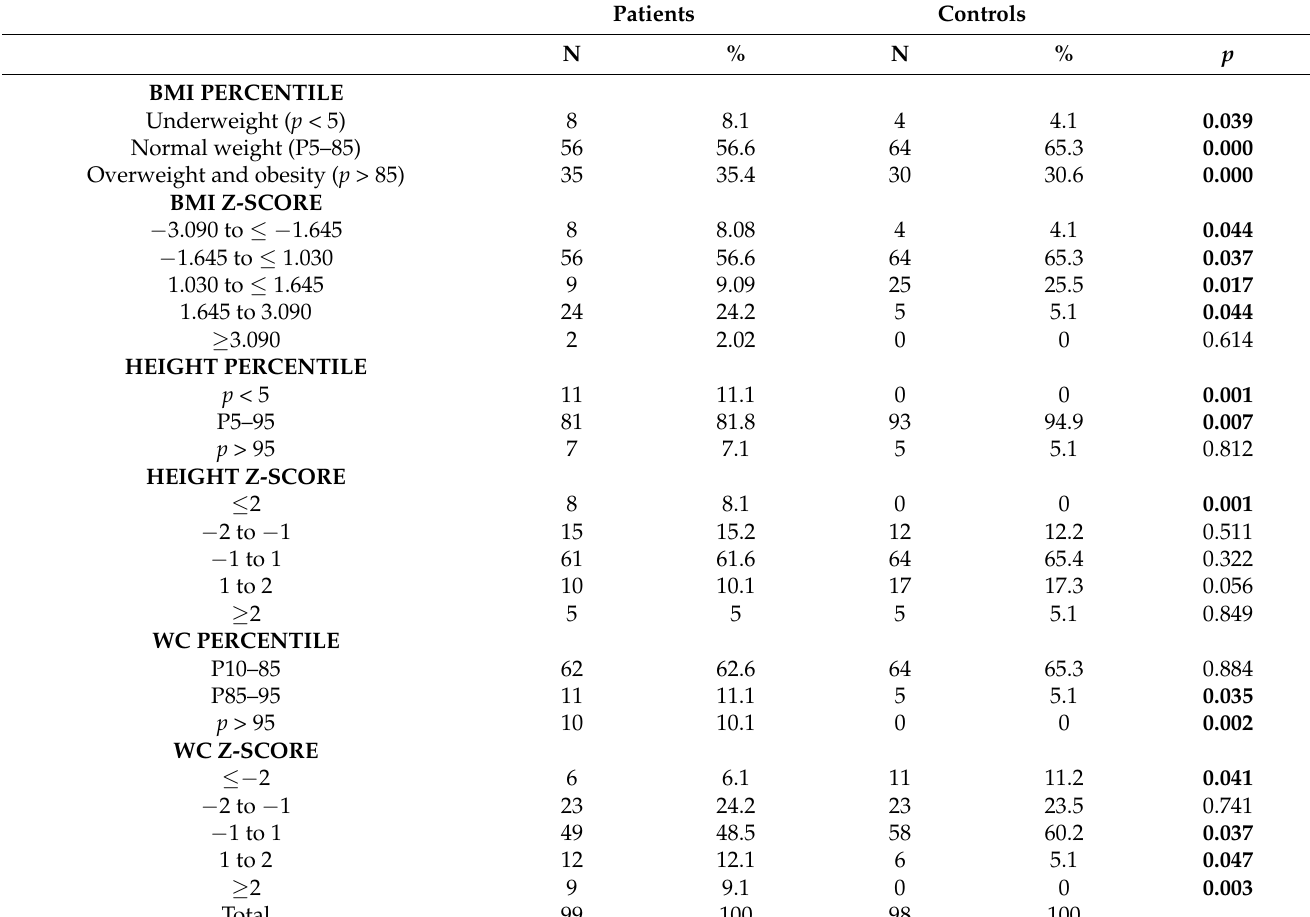
Table 2. Distribution of body mass index, height, and waist circumference percentiles and z-scores, based on WHO international